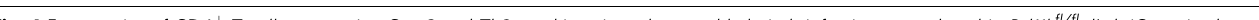
Fig. 4 Frequencies of CD4 + T-cells expressing Gata3 and Th2 cytokines in asthma and helminth infection are reduced in Bcl11b fl / fl dLck-iCre mice by an intrinsic defect. a Flow cytometry analysis of IL-4 (left column), IL-5 (middle column), and IL-13 (right column) against GATA3 in the CD4 + T-cell population of the lung parenchyma of HDM asthma-induced mice. b Frequencies of IL-4 + ( n = 4), IL-5 + ( n = 4), and IL-13 + ( n = 8) (top panel) and GATA3 + ( n = 10) (bottom panel) CD4 + T-cells from the lungs of the indicated groups. Data are derived from two (IL-4, IL-5, and IL-13 data) or fi ve (GATA3 data) independent experiments. c Flow cytometry analysis of IL-4 (left column), IL-5 (middle column), and IL-13 (right column) against GATA3 in the CD4 + T-cell population from the mesenteric (m)LNs of H. polygyrus infected mice. d Frequencies of IL-4 + ( n = 4), IL-5 + ( n = 4), and IL-13 + ( n = 4) (top panel) and GATA3 + ( n = 8) (bottom panel) CD4 + T-cells from mLNs of the indicated groups. Data are derived from two (IL-4, IL-5, and IL-13) or four (GATA3) independent experiments. e Flow cytometry analysis of GATA3 in CD4 + T-cells (left column) and IL-4 (middle and right columns) in the GATA3 hi (middle column) and GATA3 lo (right column) CD4 + T-cells from the mLNs of H. polygyrus bakeri infected mice. f The ratio of GATA3 hi /GATA3 lo CD4 + T-cells (top) and frequencies of IL-4 secreting cells within the GATA3 hi and GATA3 lo CD4 + T-cells (bottom) from the mLNs of H. polygyrus bakeri infected WT ( n = 4) and Bcl11b fl / fl dLck-iCre ( n = 3) mice. Data shown are from two independent experiments. g Flow cytometry analysis of IL-4 and GATA3 in CD4 + T-cells from the mLNs of mixed bone-marrow chimeric mice infected with H. polygyrus bakeri . Cells from WT donors are CD45.1/CD45.2, while cells from Bcl11b fl / fl dLck-iCre donors are CD45.2. h Frequencies of IL-4 + GATA3 + cells from the mLNs of mixed bone-marrow chimeric mice ( n = 6) infected with H. polygyrus bakeri . Data shown are from two independent experiments. All statistical values in this fi gure were calculated using Student ’ s t - test. All error bars shown in this fi gure are of standard